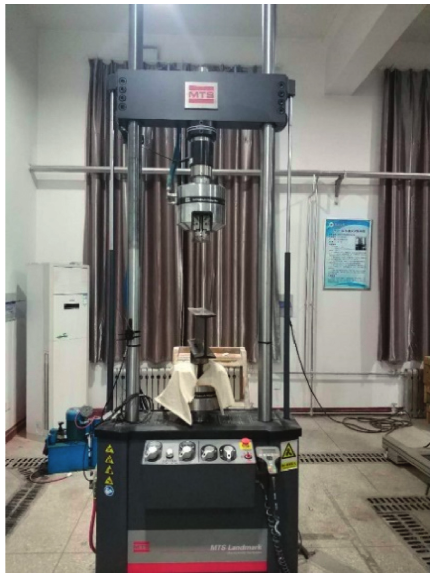
Figure 12: MTS-250 kN (servo hydraulic fatigue testing